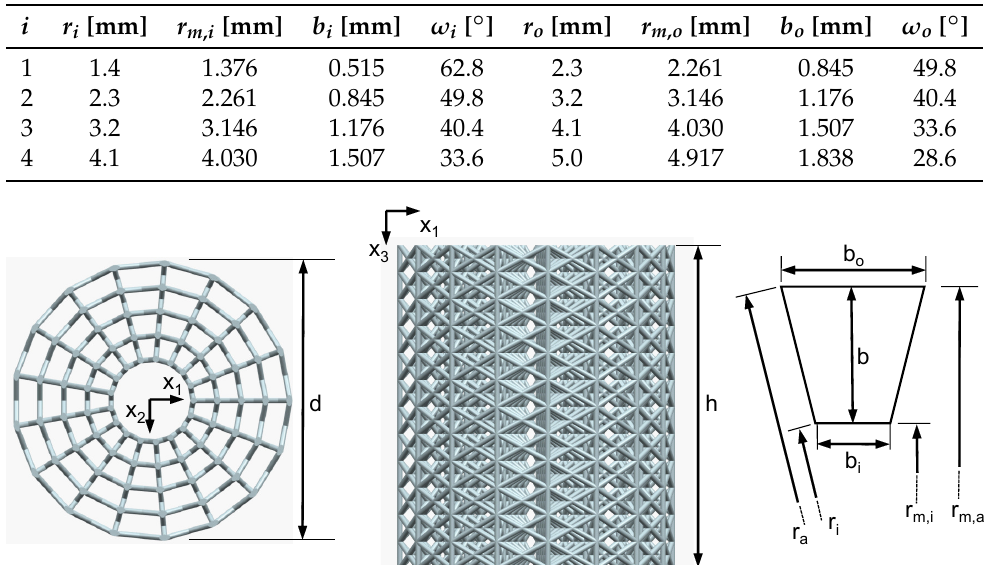
Table 1. Resulting geometric parameters of the scaffold used for this study ( R m = 1.4 mm); i defines the actual ring, starting from the middle with i = 1 according to Figure 2.